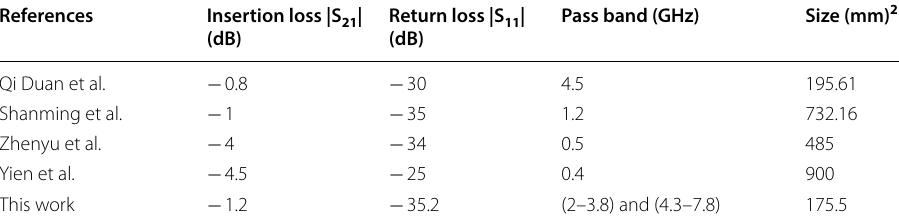
Table 2 Comparison of investigated DB-BPF with existing